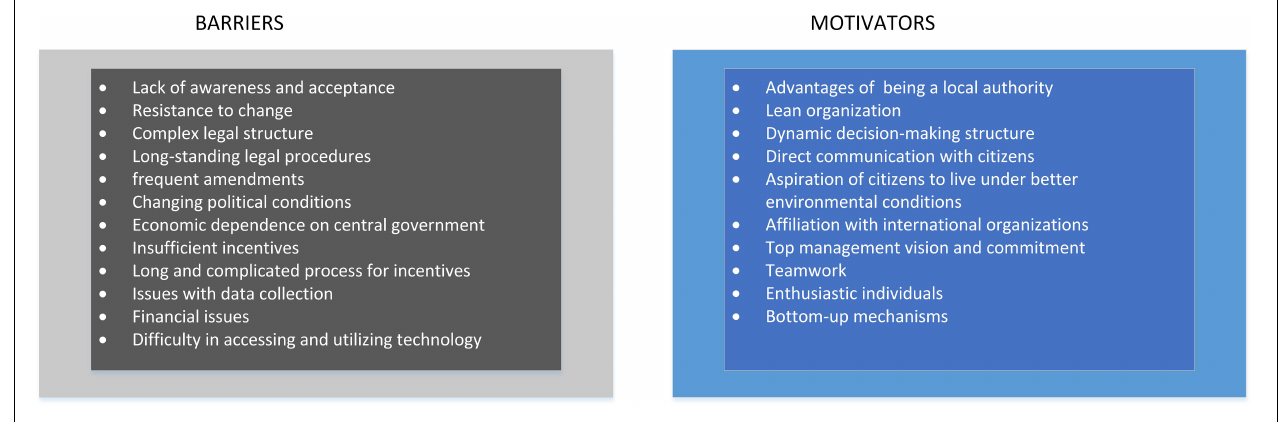
FIGURE 5 | Barriers and motivators of the Sustainable Energy Action Plan